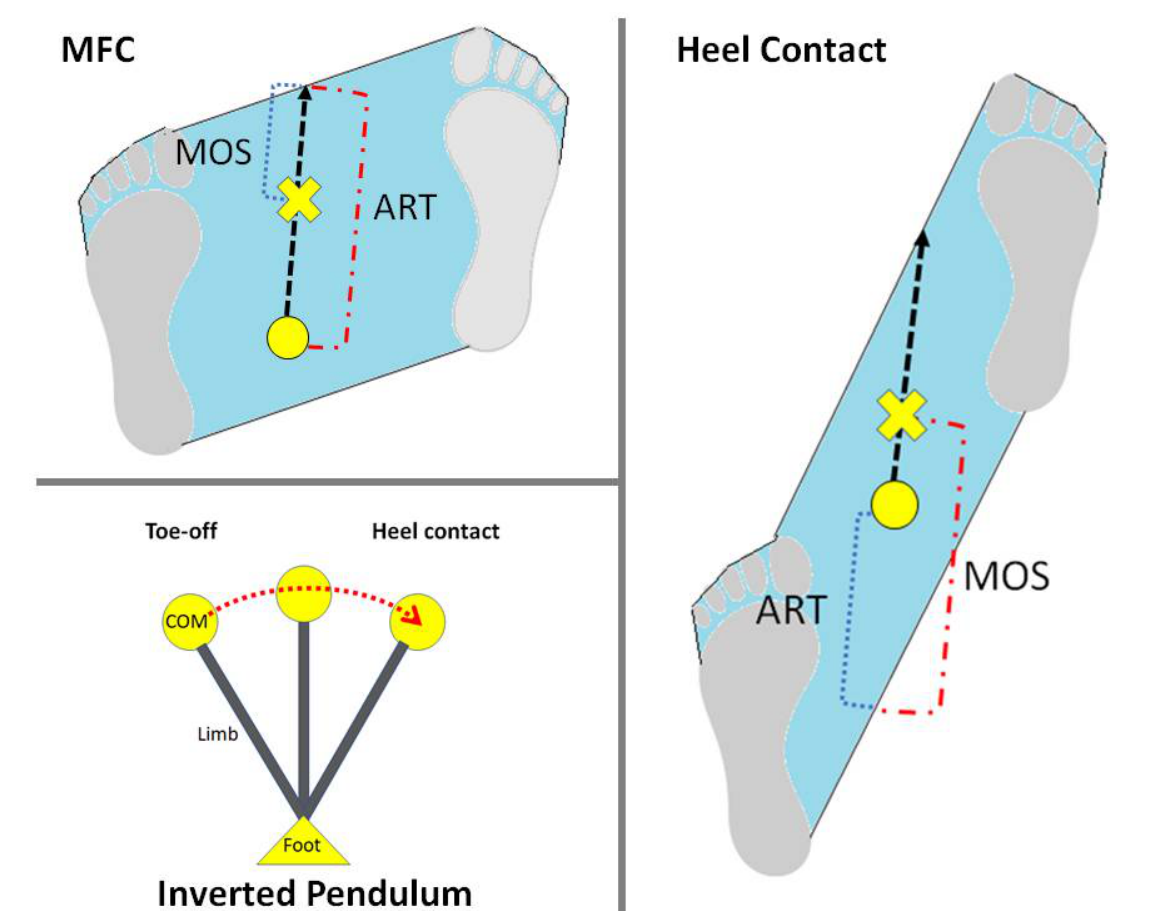
Figure 5. ( Top left ) Dynamic balance characteristics at MFC—tripping-related COM indicated by a circle, XCOM indicated by X, ( bottom left ) inverted pendulum model during single support; ( right ) dynamic balance characteristics at heel contact—slipping related; MOS = margin of stability COM indicated by a circle, XCOM indicated by X. ART = available response time, COM = centre of mass. XCOM = COM + COMvelocity + √g/l, where g = gravitational acceleration and l = limb length; MOS = BOS—XCOM as illustrated above.